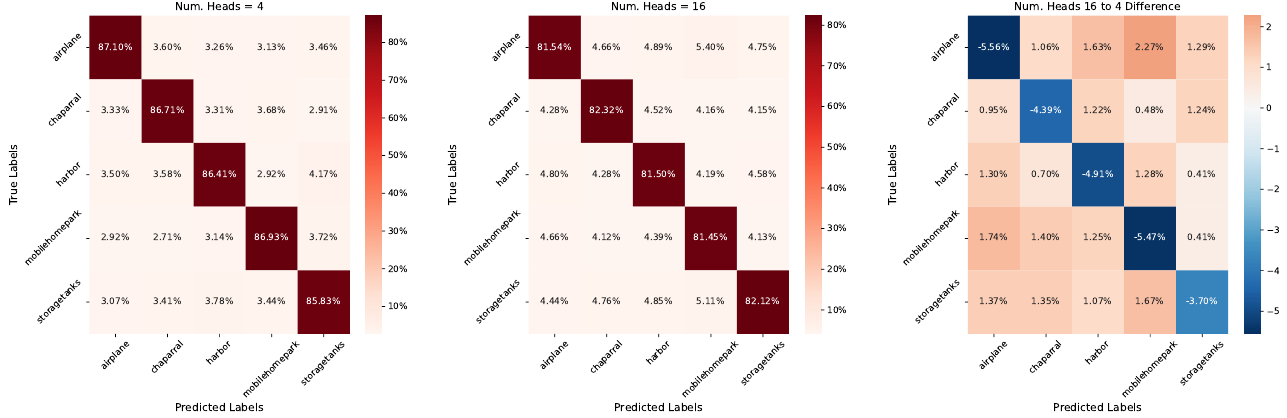
Figure 12. Confusion matrices and their difference on dataset UC Merced with graph transformer attention heads equaling 4 and